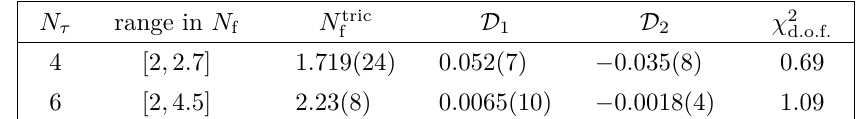
Table 3. Fits of the data in figure 7(a) to eq.